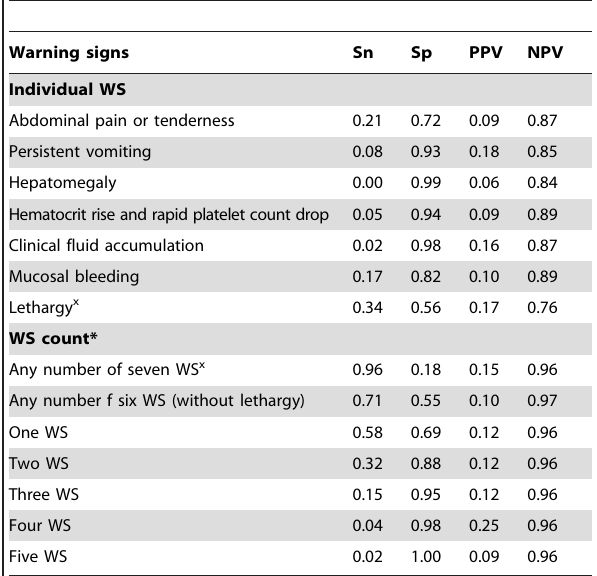
Table 4. Performance of warning signs (WS) for predicting severe dengue (SD) (n=1507).